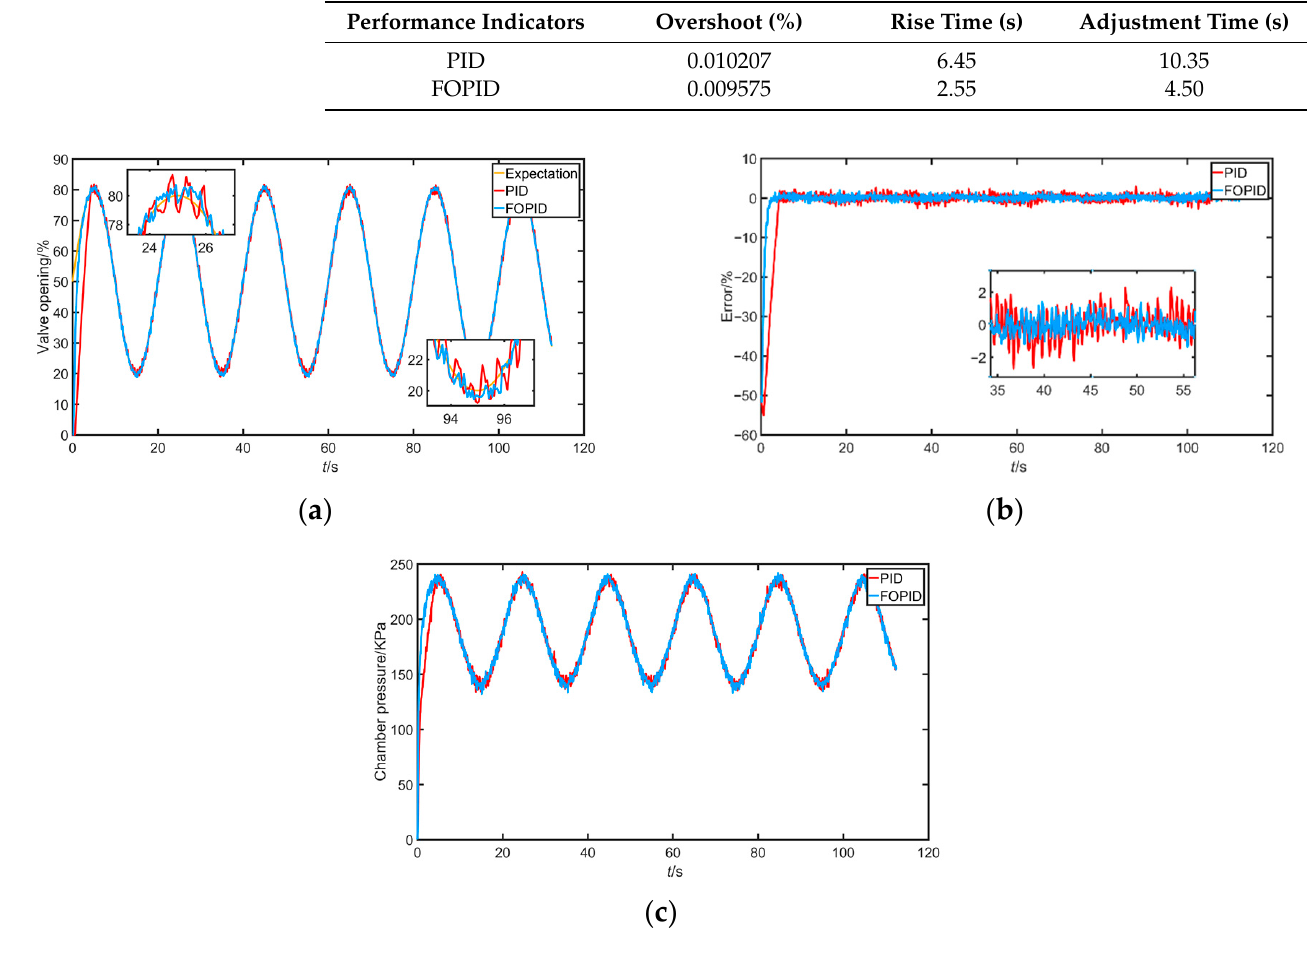
Figure 19. ( a ) Response signal under sinusoidal tracking; ( b ) error of response signal under sinusoidal tracking; ( c ) corresponding air chamber pressure under sinusoidal signal.